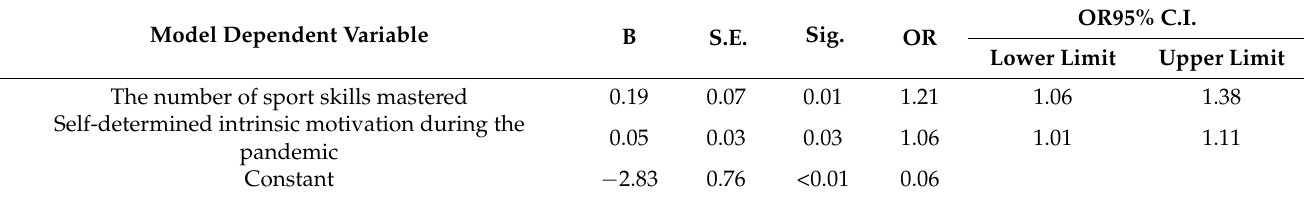
Table 6. Related factors of exercise behavior change among participants who achieved the guidelines for MVPA before the pandemic.